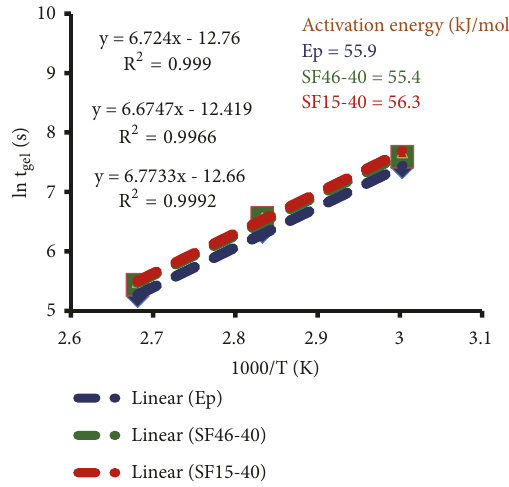
) versus 1/temperature. gel